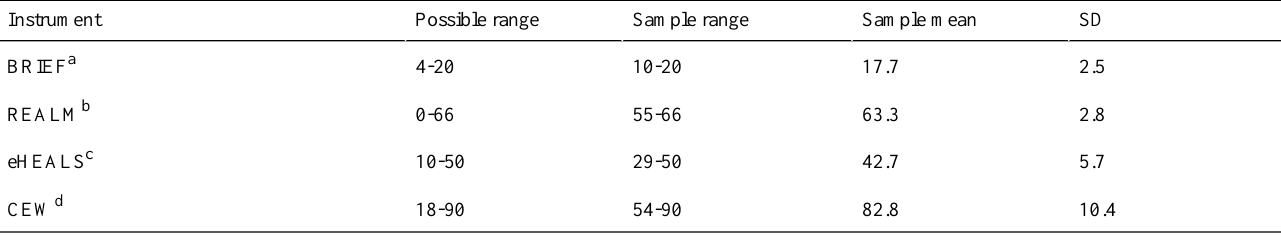
Table 2. Instrument range, sample range, mean, and standard